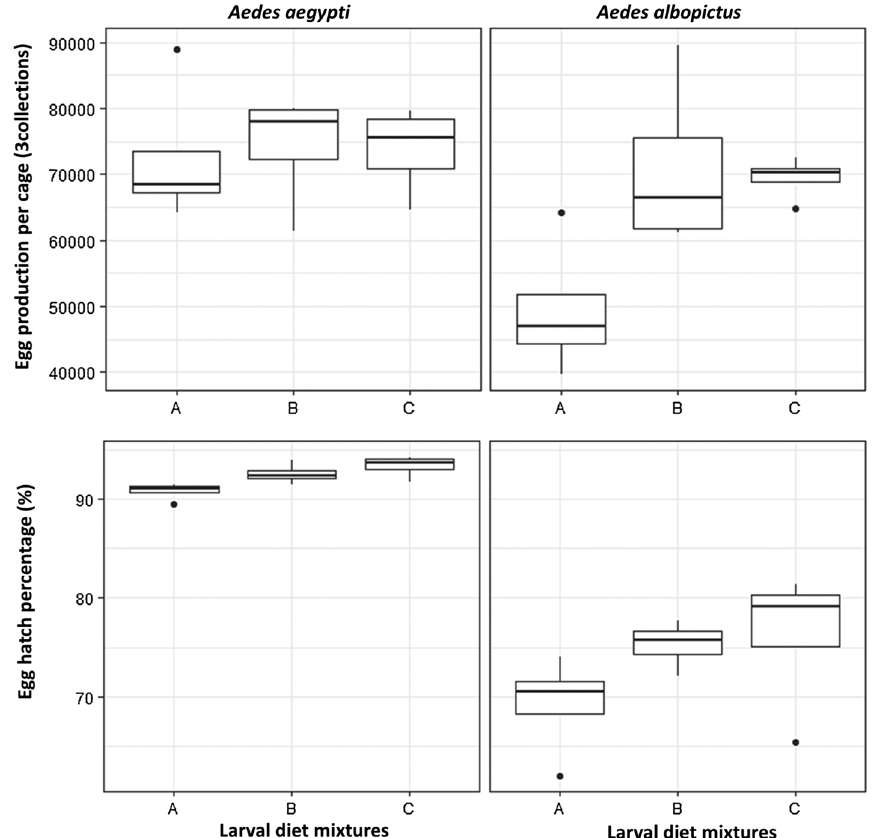
Figure 3. Egg production over three gonotrophic cycles and egg hatch rate in Aedes aegypti and Aedes albopictus. Diet A = 50% TM + 35% BLP + 15% BY, Diet B = 50% TM + 35% BSF + 15% BY, Diet C = 50% TM + 50%